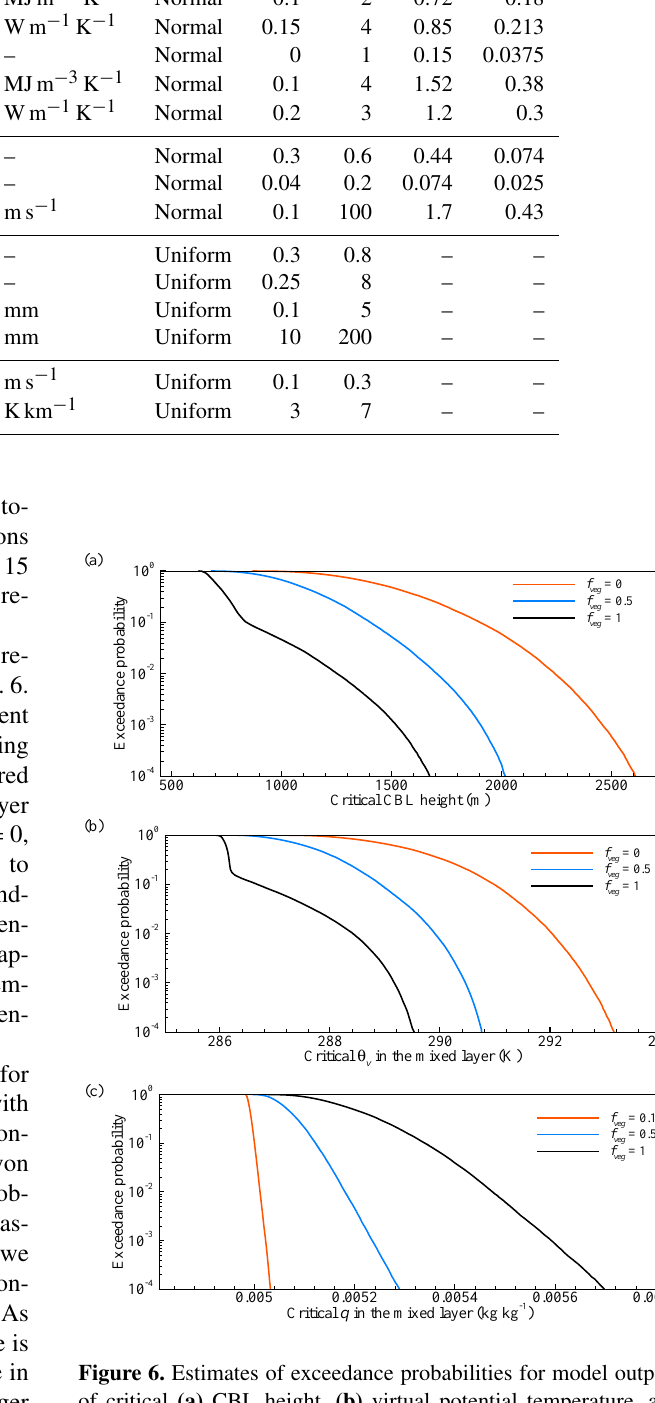
Figure 6. Estimates of exceedance probabilities for model outputs of critical (a) CBL height, (b) virtual potential temperature, and (c) specific humidity with different green roof